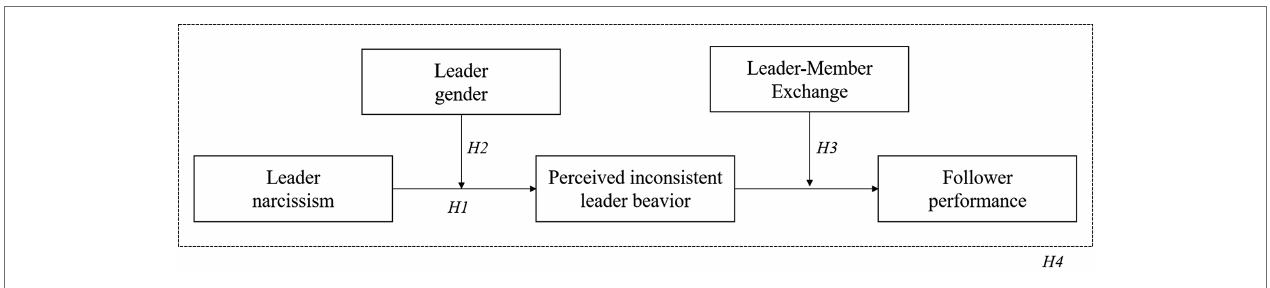
FIGURE 1 | Proposed moderated mediation